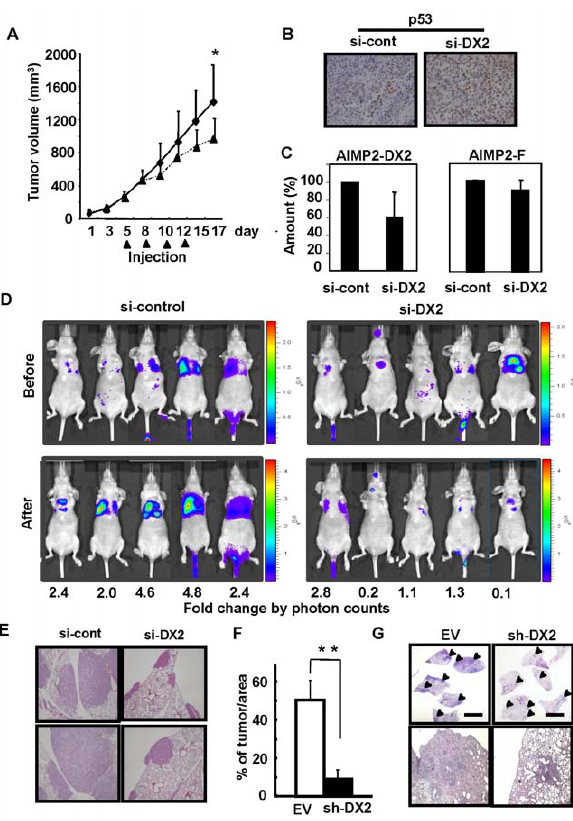
Figure 7. Knock-down of AIMP2-DX2 can retard tumor growth. (A) NCI-H460 (1 6 10 7 ) cells were injected at both flanks of 6 week old BALB/c nude mice. When volume of tumor mass reached to 250 mm 3 , anti-DX2 or control siRNAs were intratumorally injected at 50 mg/kg dosage once in three days for four times (n=7 per each group). The tumor volumes were determined as described in Materials and Methods. (B) Tumors isolated from anti-DX2 and control siRNA treated mice were subjected to immunohistochemistry with the antibodies against p53 (C) Cellular levels of AIMP2-F and –DX2 transcripts in the tissues of the isolated tumors were compared by quantitative RT-PCR. (D) Luciferase-expressing A549 lung cancer cells (1 6 10 7 ) were injected into tail vein of BALB/c nude mice and the dissemination of the cells into lungs was monitored by IVIS (Xenogen). Each group of the injected mice (n=5/group) intratracheally received si-scramble (50 m g) or si- AIMP2-DX2 (50 m g) mixed with GDM-PEI in 50 m l of 0.9% saline. The tumor growth was monitored by photon flux released from luciferin as described in Materials and Methods. The data were expressed as photon-flux (photons/s/cm2/steradian). The photon flux for each measurement is represented by color scale. (E) Tumor tissues isolated from each group were examined by hetatoxylin and eosin staining. Two examples from each group are displayed. (F) The plasmid DNA encoding shRNA against AIMP2-DX2 was mixed with glucosylated polyethyleneimine (G-PEI), vaporized in humid vacuum chamber and inhaled for 30 minutes through the nose of the mice that contained benzopyrene-induced lung cancers as described in Materials and Methods. The mice were randomly sacrificed at time interval and the tumor growth was determined by the area of tumor tissues in the total measured area (n=4). (G) Histological analysis of tumor regions by hematoxylin and eosin staining. Arrow heads indicate tumor nodules.